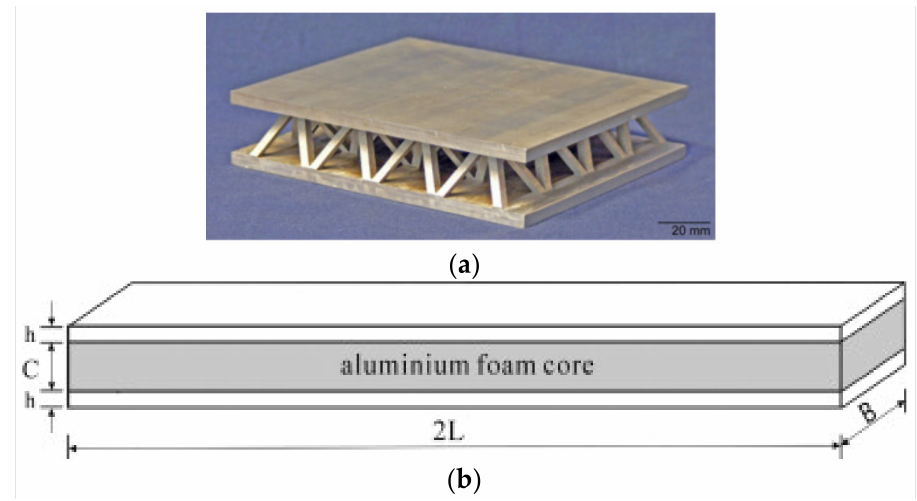
Figure 4. ( a ) Lattice sandwich structure [17]; ( b ) Aluminum foam core design